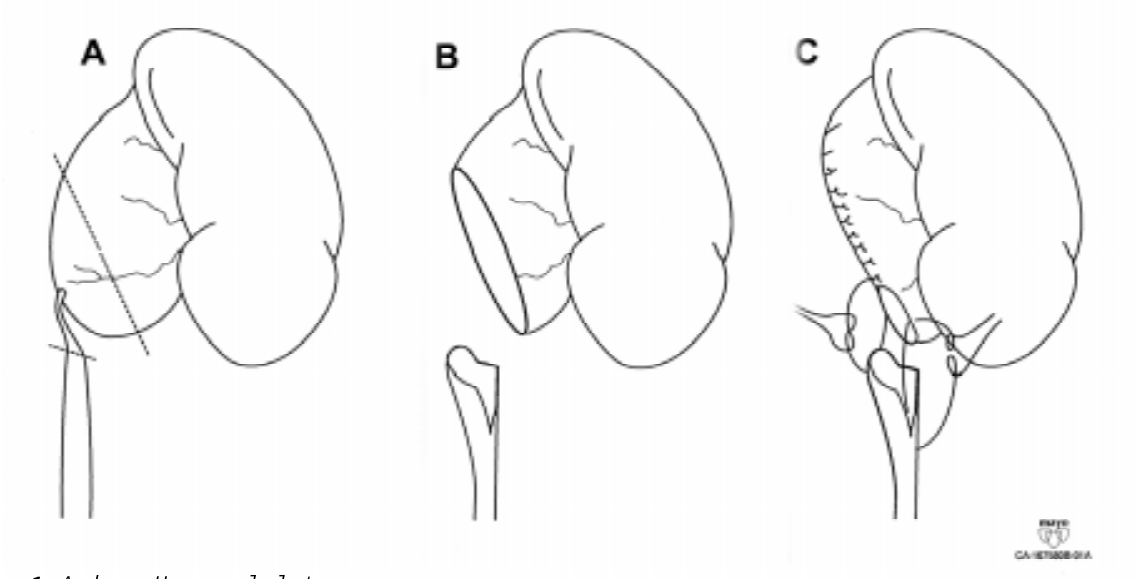
Figure 1 - Anderson-Hynes pyeloplasty.